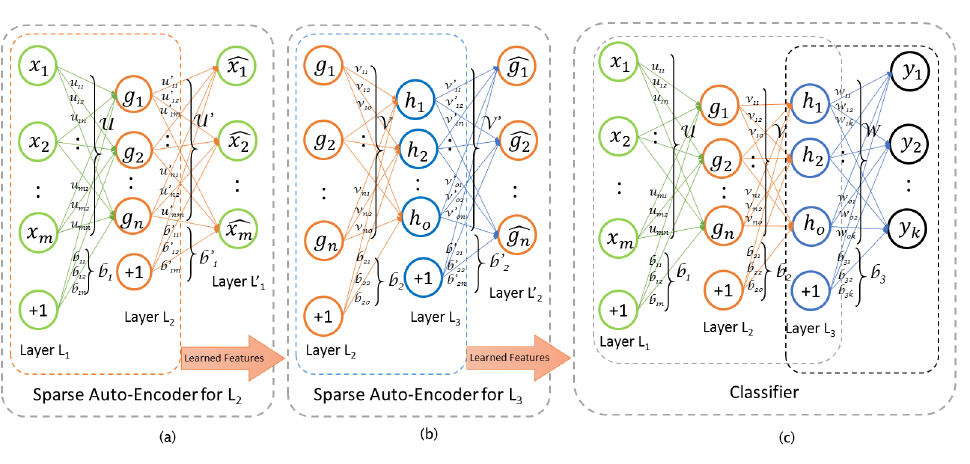
Figure 2. A stacked autoencoder based deep learning